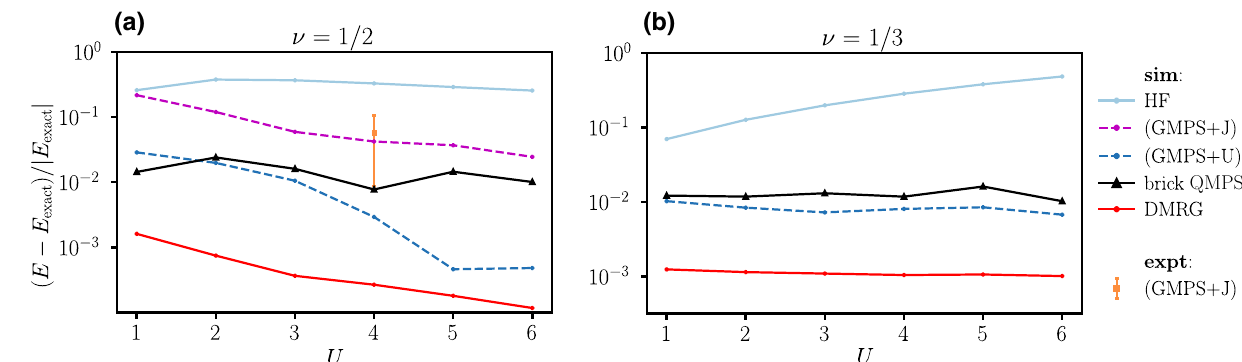
FIG. 3. Comparison of variational approaches to the Fermi-Hubbard chain—relative error in energy of (a) half-filling (b) (1/3)-filling Fermi-Hubbard chain for various variational approaches compared to the exact ground state of the corresponding Fermi-Hubbard chain. Variational approaches include two types of GMPS+X circuits: GMPS + J and GMPS + U that augment the GMPS with B = 6 for the Hartree-Fock ground state with additional variational circuitry, and a problem-agnostic QMPS ansatz with two bond qubits and four layers of brick circuit (brick QMPS) (see Appendix B for details of circuit ansatzes). The GMPS+U simulations are performed for an L = 18 site chain, whereas the brick QMPS and DMRG calculations are performed for an infinite chain. For comparison to classical methods, we include the mean-field (MF) solution, and DMRG results with bond dimension 2 5 that provide a lower bound on the achievable energy with n b = 5 bond qubits ( n b = B − 1 in general) used in the GMPS+U approach. The number of variational parameters per (spinful) site are, respectively, 1 (GMPS+J), 30 (GMPS+U), 80 (brick QMPS), and 1024 (DMRG with χ = 2 5 ).